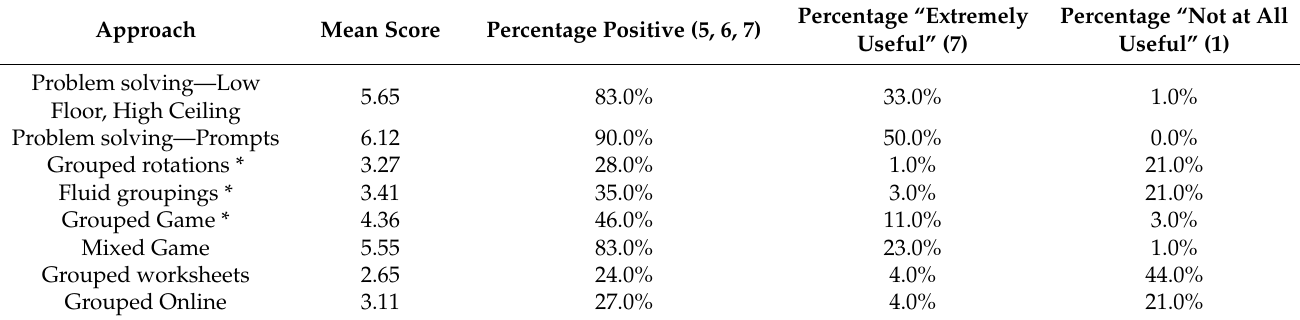
Table 4. Post-intervention ( n = 100) teacher